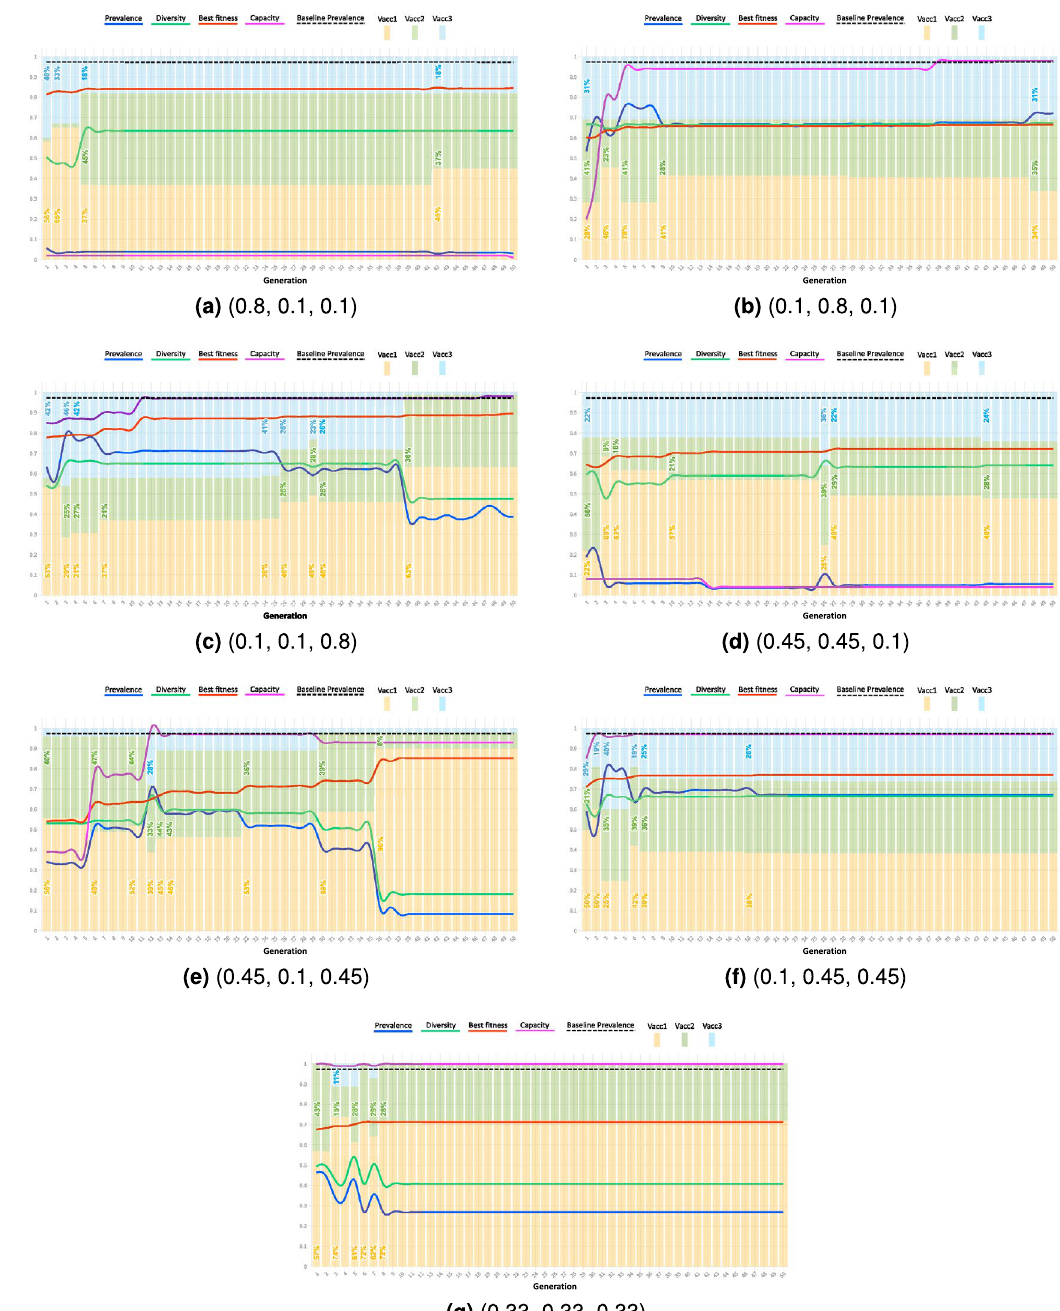
Figure 3. Evaluation of different control strategies under different fitness function weights of the genetic algorithm. The weight of each fitness function parameter from Eq. (9) is given under each plot ( K 1 , K 2 , K 3 ) which represents the policy objective being optimized. Capacity and vaccine groups are given as a proportion of the entire population. Prevalence is given as a metric calculated from Eq. (6). Diversity is calculated from Eq. (7) and a larger value represents a more diverse population. A trade-off is seen between strategies that focus on decreasing prevalence and increasing diversity. An increase in the population vaccine diversity results in increased prevalence. A focus on decreasing the disease prevalence results in low capacity but still allows for diversity to be present. No clear trends emerge when focusing on capacity alone due to not placing emphasis on diversity and